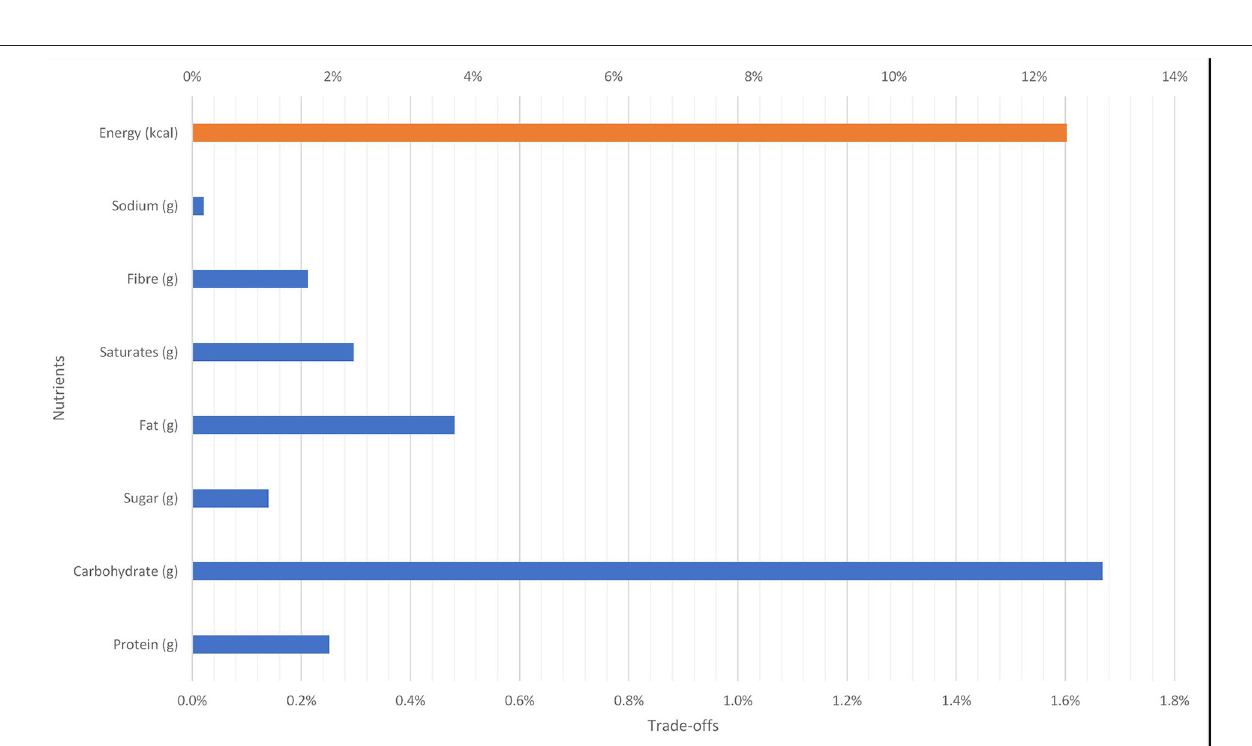
FIGURE 9 | Nutritional trade-off due to 10 per cent reduction in the price of mashed potatoes on new potatoes baby.